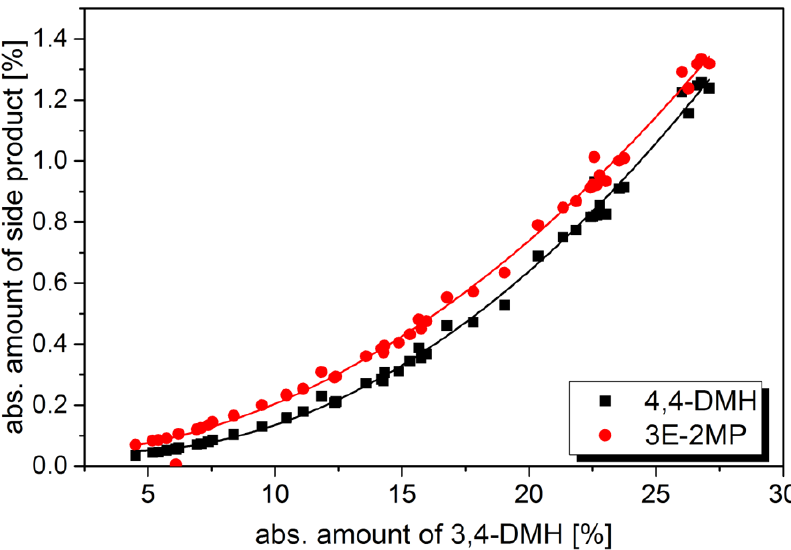
Figure 3. Absolute amount (in wt.%) of 4,4-dimethylhexene (4,4-DMH) and 3-ethyl-2-methylpentene (3E-2MP) at different feed rates versus absolute amount of 3,4-DMH in product stream at the constant mass of amorphous aluminosilicate in proton form, 100 °C reaction temperature and 30 bar (liquid phase); trend line with equations, coefficient of determination and scheme of the competing reactions.